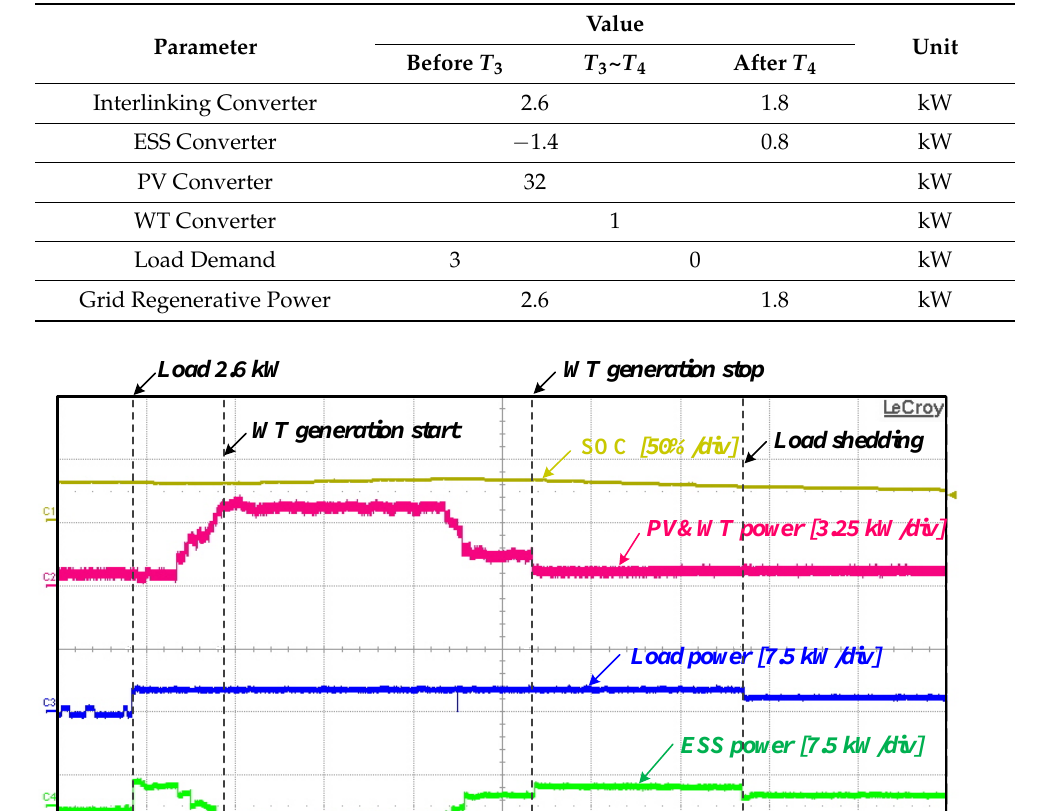
Table 8. Power flow of each power converter in operation mode 5.